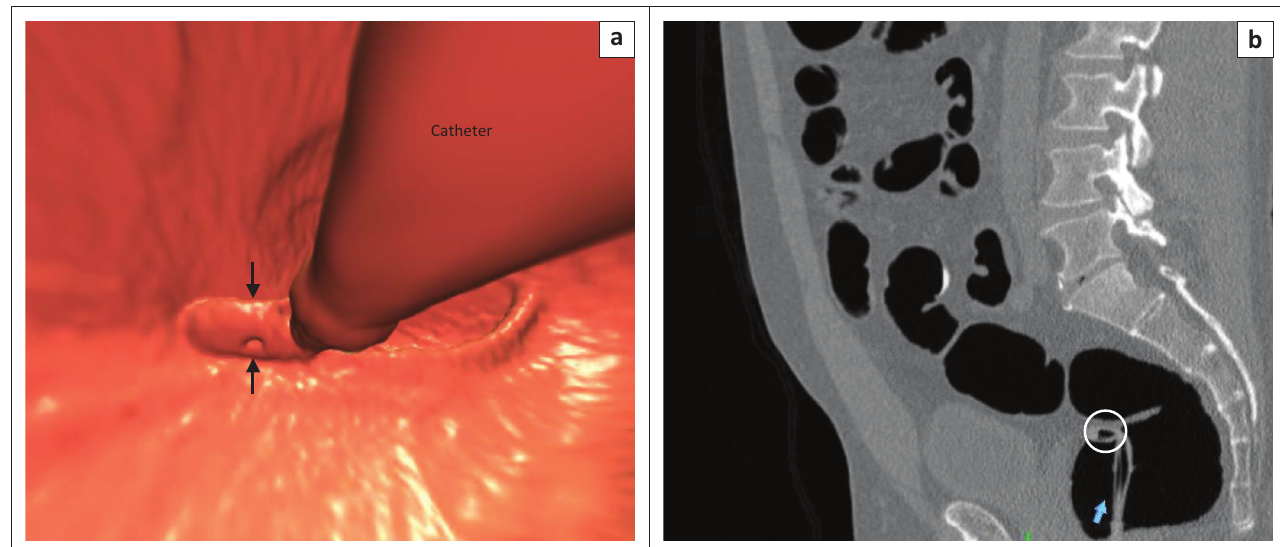
FIGURE 6: (a) 3D view shows kinking of tube (black arrows); (b) 2D view shows tip of rectal tube bent to 90° (white circle). This obstructs flow of CO